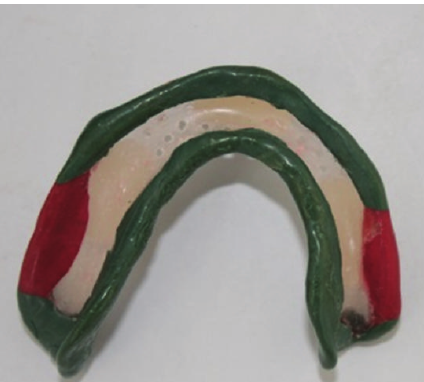
Figure 8: Mandibular custom tray fabricated with clear acrylic resin.